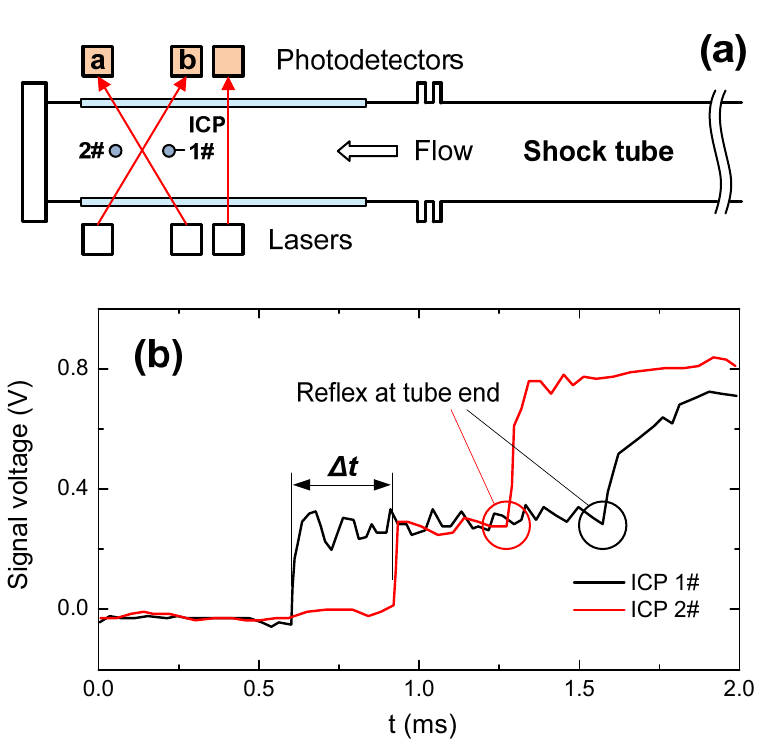
Figure 6. ( a ) ICP sensor locations and ( b ) responses for a pressure wave in the shock